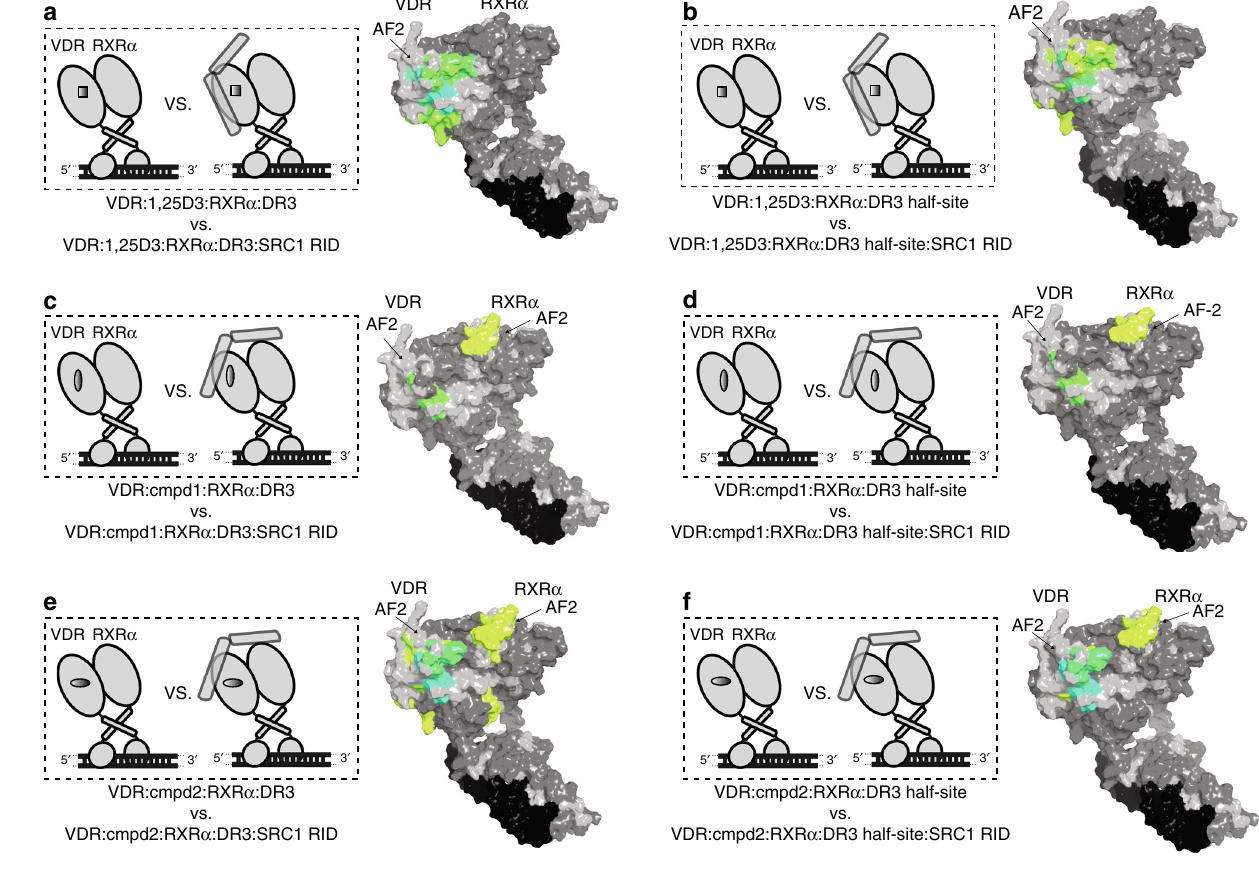
Fig. 4 Ligand dependency of SRC1 RID binding to the VDRRXR α heterodimer AF2 surface. Schematic representations illustrate differential experiments of VDRRXR α : ligand: DNA complex verse VDRRXR α : ligand: DNA: SRC1 RID complex (on the left). Differential HDX data are mapped onto the surface of VDRRXR heterodimer structure model in the presence and absence of SRC1 RID (on the right). a Conformational changes of VDRRXR α : 1,25D3: DR3 complex upon SRC1 RID binding (Supplementary Fig. 1b, d, column (xi)). b Conformational changes of VDRRXR α : 1,25D3: DR3 half-site complex upon SRC1 RID binding (Supplementary Fig. 1b, d, column (xii)). c Conformational changes of VDRRXR α : Cmpd1: DR3 complex upon SRC1 RID binding (Supplementary Fig. 1b, d, column (xiii)). d Conformational changes of VDRRXR α : Cmpd1: DR3 half-site complex upon SRC1 RID binding (Supplementary Fig. 1b, d, column (xiv)). e Conformational changes of VDRRXR α : Cmpd2: DR3 complex upon SRC1 RID binding (Supplementary Fig. 1b, d, column (xv)). f Conformational changes of VDRRXR α : Cmpd2: DR3 half-site complex upon SRC1 RID binding (Supplementary Fig. 1b, d, column (xvi)). Percentages of deuterium differences are coded as Fig. 1. Dark gray, no statistically signi fi cant changes between compared conditions; light gray, regions that have no sequence coverage and include proline residue that has no amide hydrogen exchange activity; black, DNA